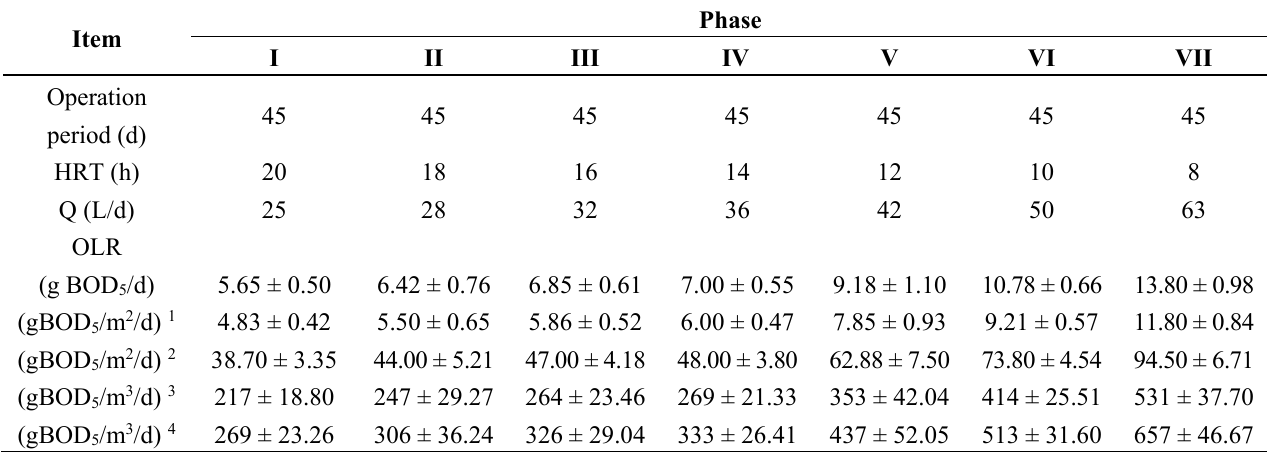
Table 1. Experimental operating conditions of the Bio-hedge water hyacinth wetland system treating domestic